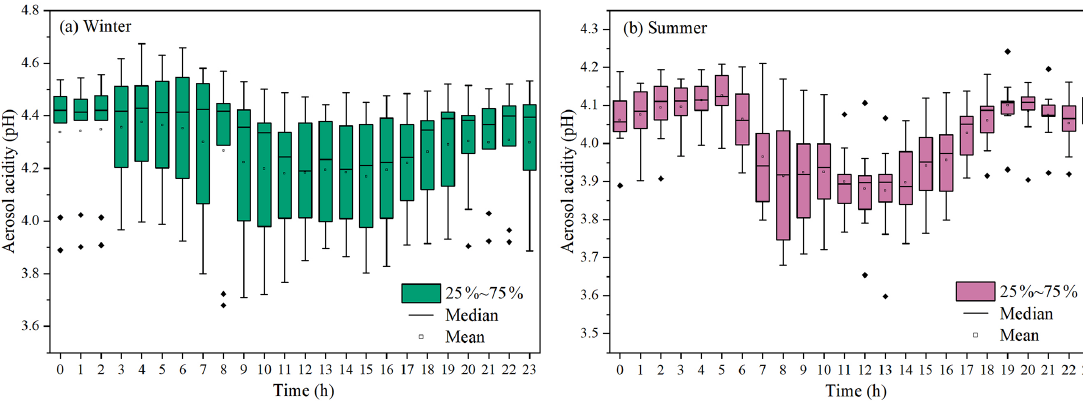
Figure 4. Diurnal variations of aerosol acidity (pH) during the wintertime (a) and summertime (b) period. (The boxes with error bars represent the 10th, 25th, 75th, and 90th